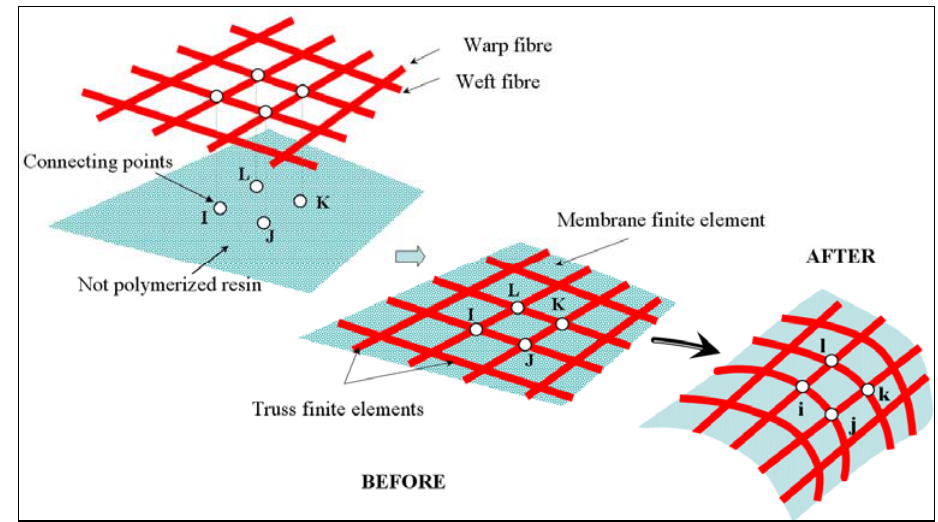
Figure 3. Mechanical deformation of composite